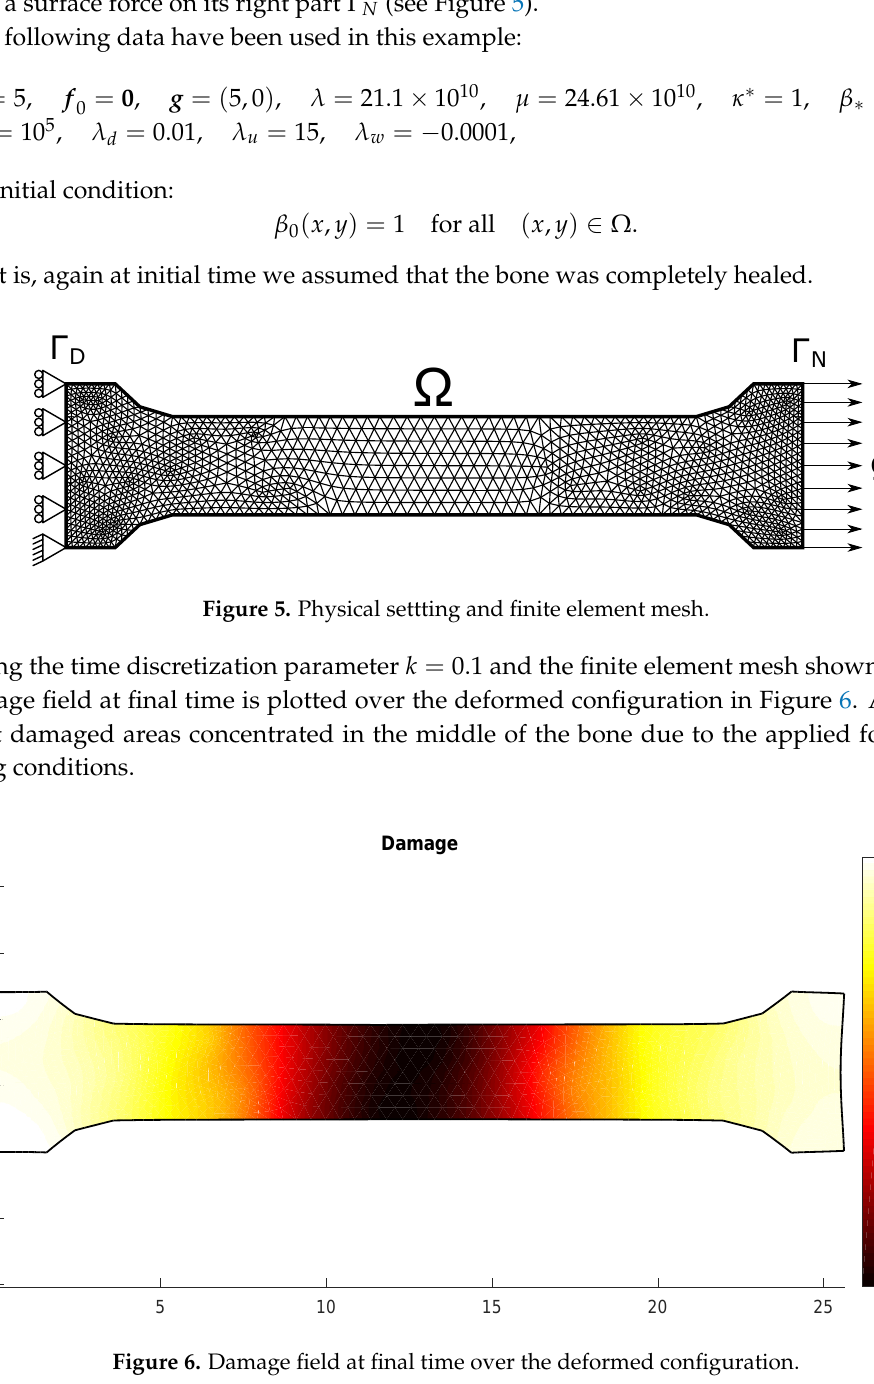
Figure 6. Damage field at final time over the deformed configuration.